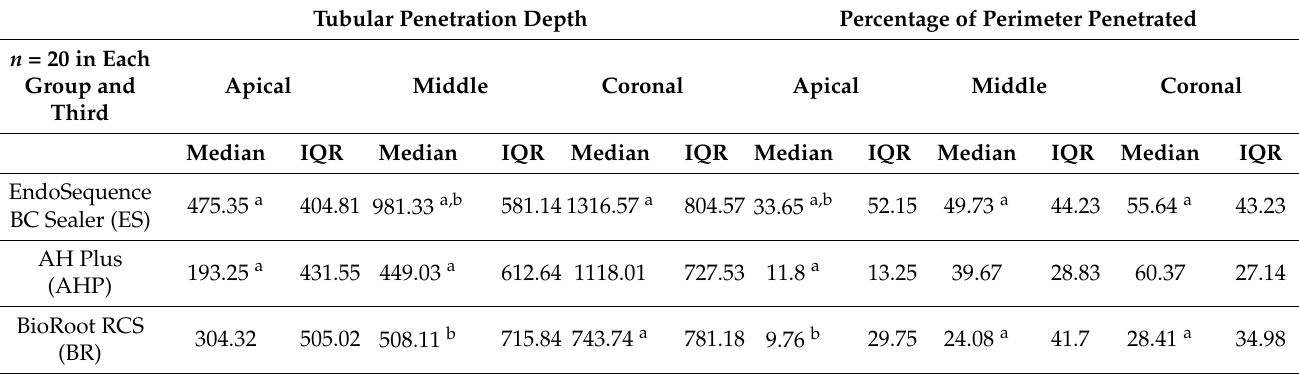
Table 2. Cement penetration depth inside dentinal tubules, divided by thirds and